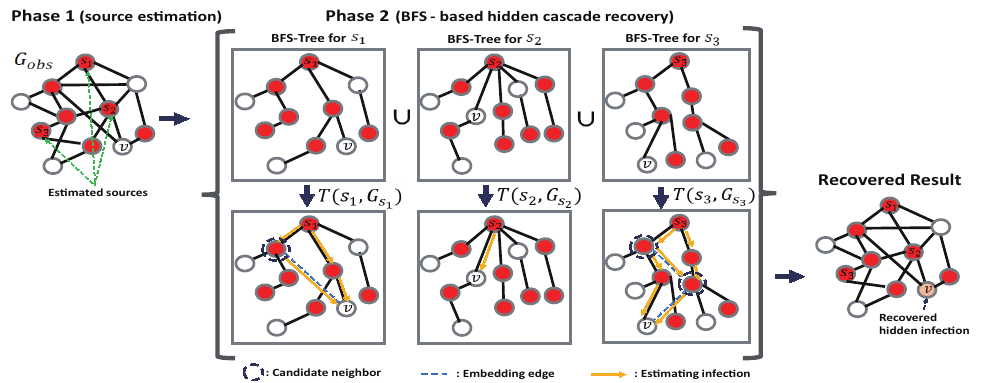
Figure 4. Illustration example of the Algorithm BSRA for m = 3. The BSRA first estimates the sources for a given m , then it makes m different BFS trees with respect to each source s i ( i = 1,2,3 ) . Next, for ) for each s each node v ∈ V \ V I , the BSRA reconstructs graph T ( s i , G s i (see Figure 3) and computes i ) . After computing the diffusion probability from the sources, the infection probability using T ( s i , G s i it finally recovers the hidden infected node based on the criteria, as in the right